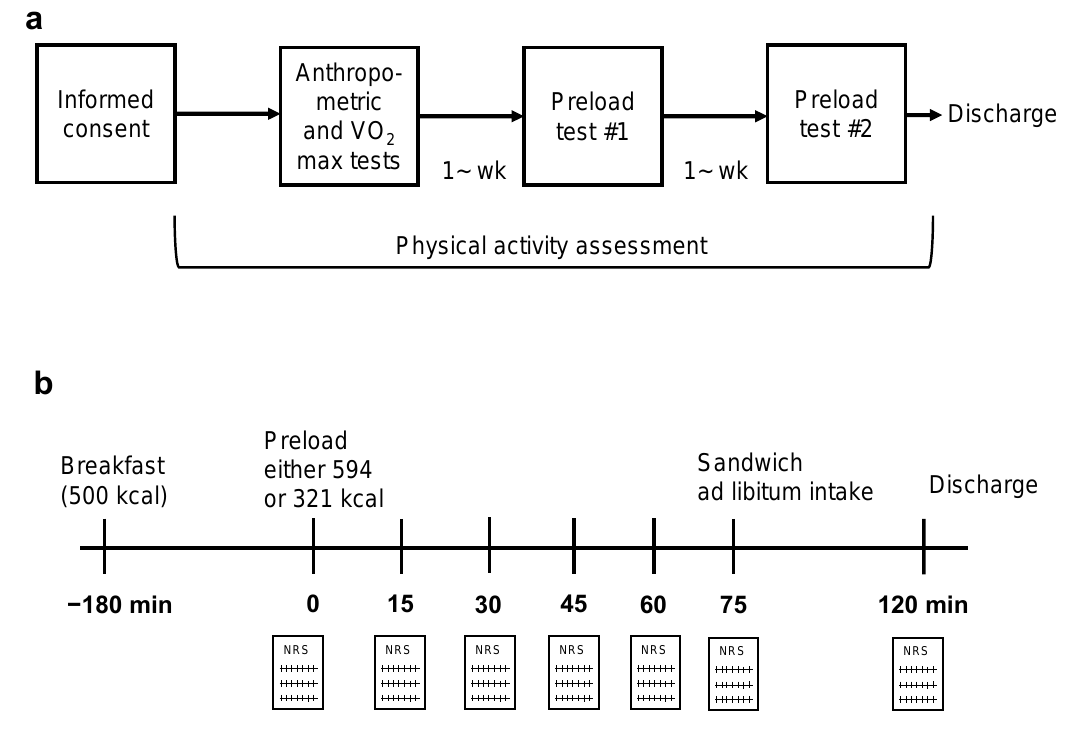
Figure 1. Schematic of the study protocol. ( a ) A flow diagram of the sequence of study procedures. Participants were randomly assigned two energy load conditions after performing anthropometric and VO 2 max tests. ( b ) An overview of the preload experiment. Participants had a standardized breakfast 3 h prior to preload drinking. Seventy-five minutes after the preload, participants ate sandwiches ad libitum. Legend: NRS, numerical rating scale. Table 1. Contents of liquids for each energy load